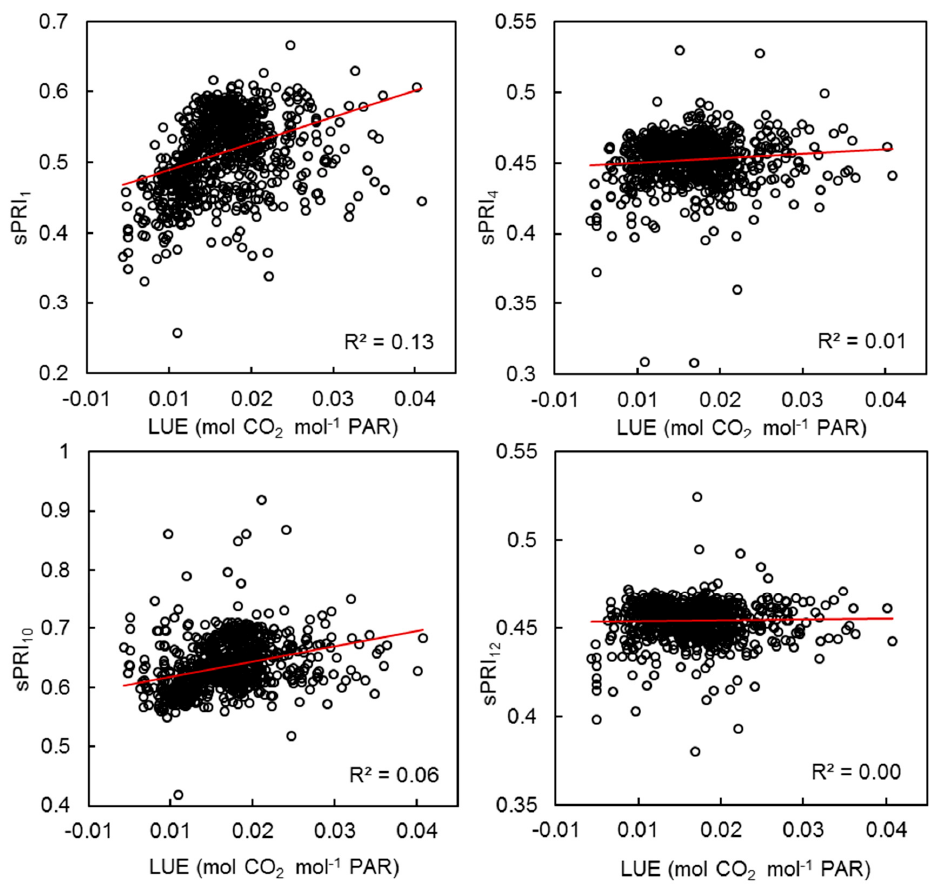
Figure 6. The relationships between the four different PRIs and flux tower measured light use efficiency (LUE). The red lines are a simple linear regression lines.